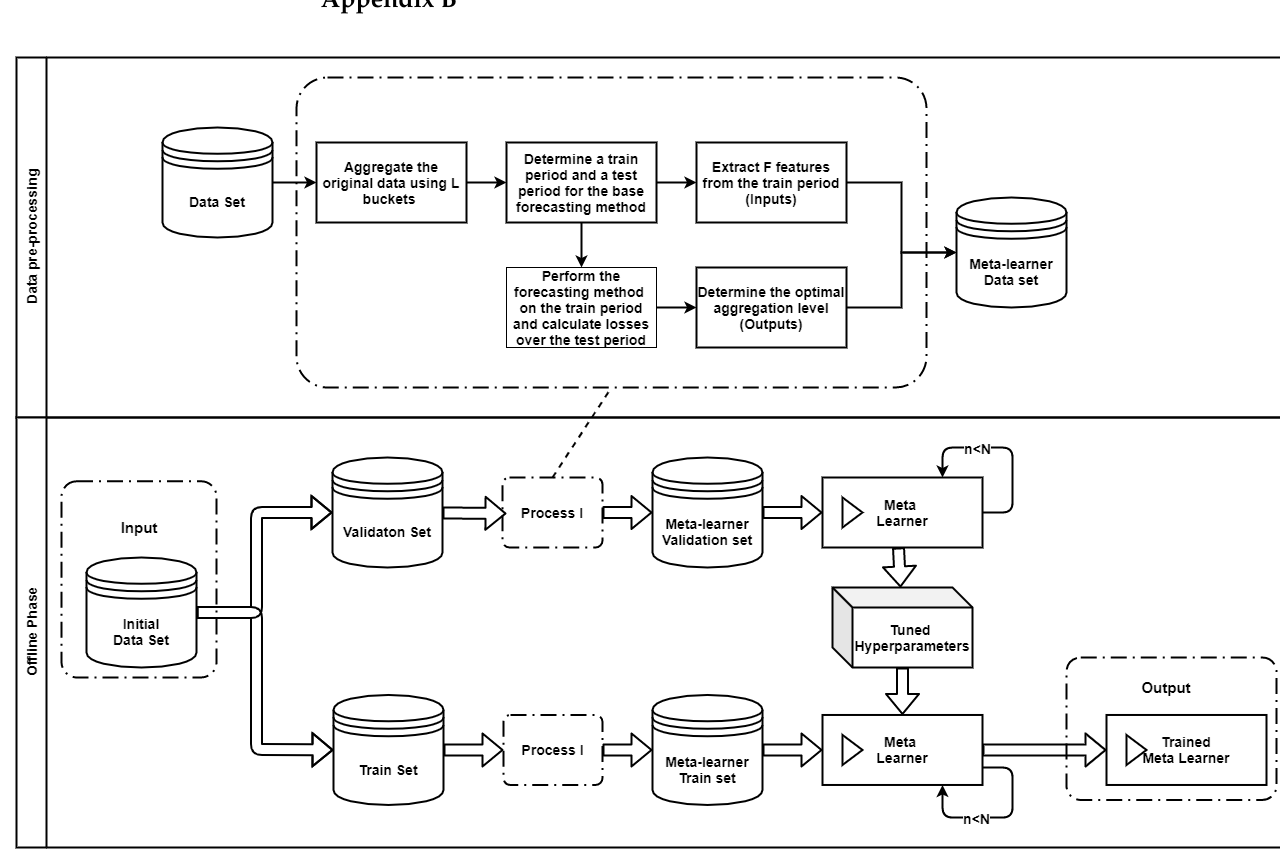
Figure A1. The offline phase of the proposed framework.